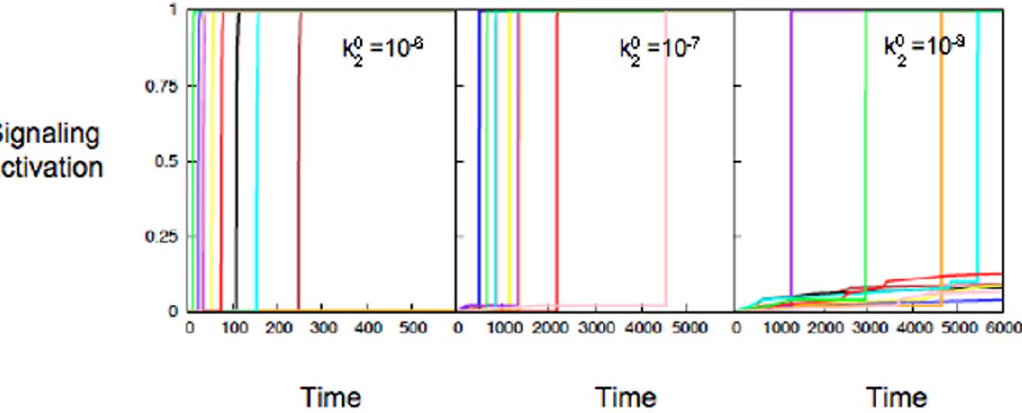
Figure 5. The slow step in the type B pathway modulates cell-to-cell stochastic variability. Activation of x 3 molecules at the single cell level for various values of the rate constant for the slow intermediate step (type B pathway): 10 { 6 (left) , 10 { 7 (middle), and 10 { 8 (right) stimuli. Different colors correspond to different individual cells.